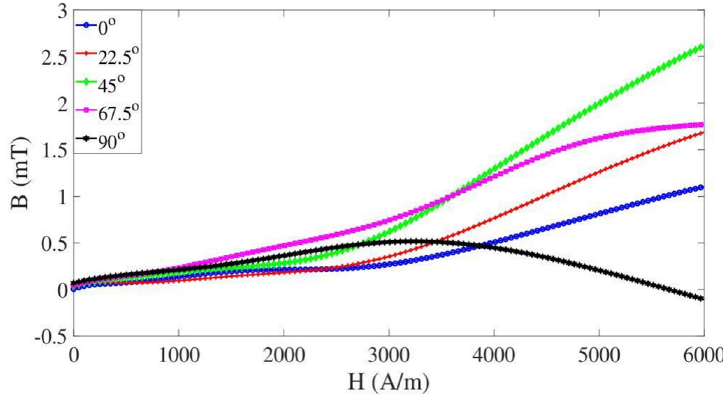
Figure 9. Magnetization curves for specimen 1 at different angles θ under a stress of 80 MPa.